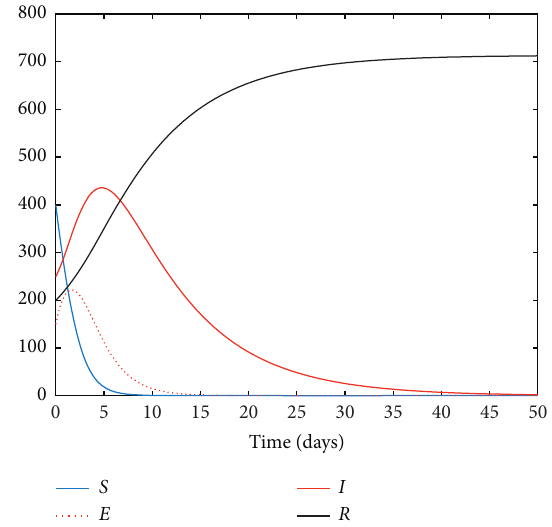
Figure 1: Evolution of the populations in the absence of external control actions.